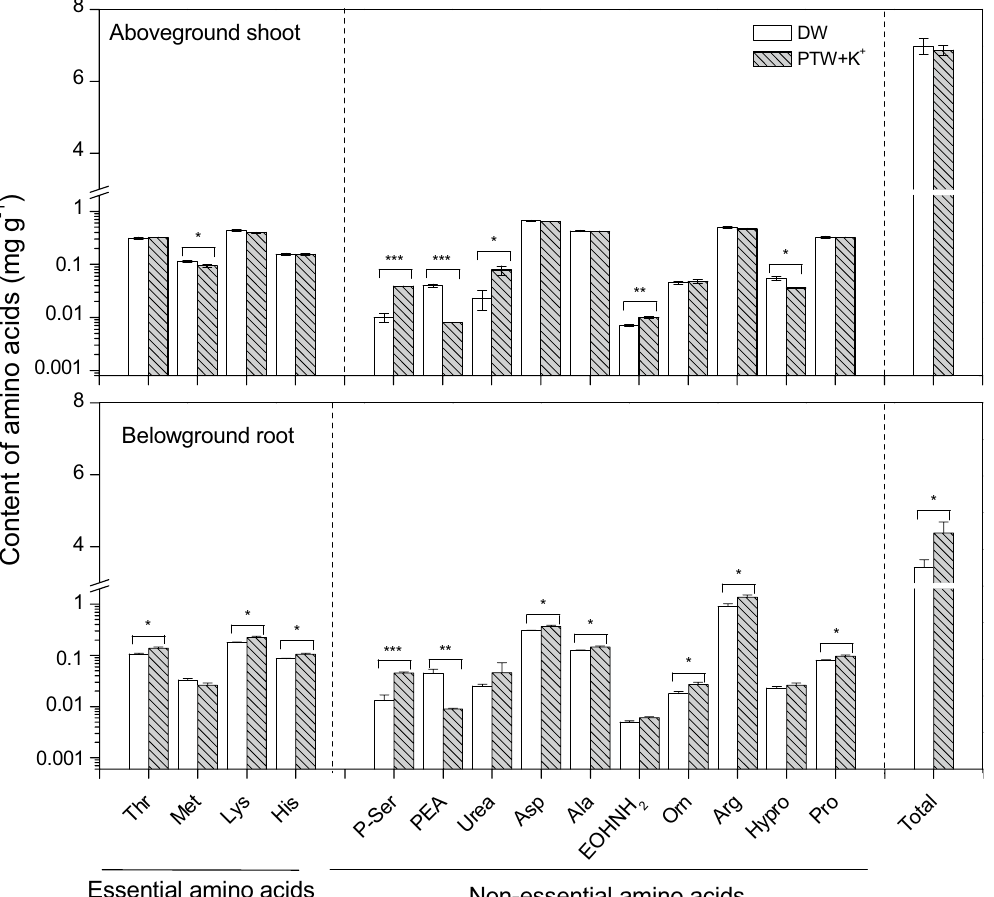
Figure 2. Total contents of the 14 free amino acids of Panax ginseng at 25 days after planting, each sprayed with deionized water (DW) and plasma-treated water (PTW) containing potassium ions (K + ) up to 25 days. The fourteen free amino acids include 4 essential amino acids (threonine (Thr), methionine (Met), lysine (Lys), and histidine (His)) and 10 non-essential amino acids (phosphoserine ( P -Ser), phosphoethanolamine (PEA), urea, aspartic acid (Asp), alanine (Ala), 2-aminoethanol (EOHNH 2 ), ornithine (Orn), arginine (Arg), hydroxyproline (Hypro), and proline (Pro)). Each bar represents the mean of four replicates with each replicate containing three shoots (or roots). The error bars represent the standard error of that mean. An asterisk indicates a significant difference between the DW and PTW + K + at 25 days ( P <